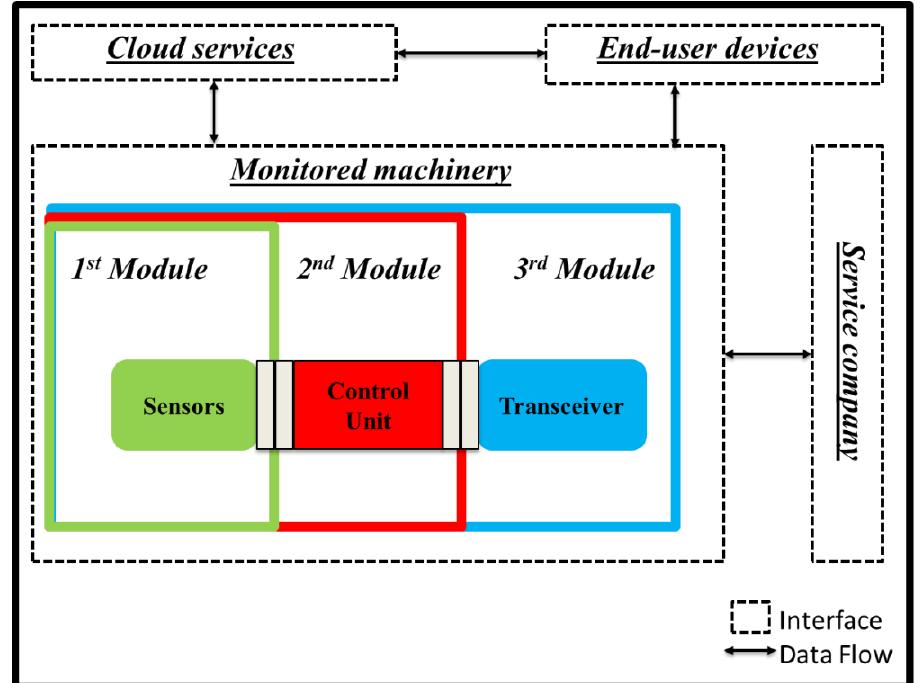
Figure 10. The IoT DAQ for legacy production machinery.